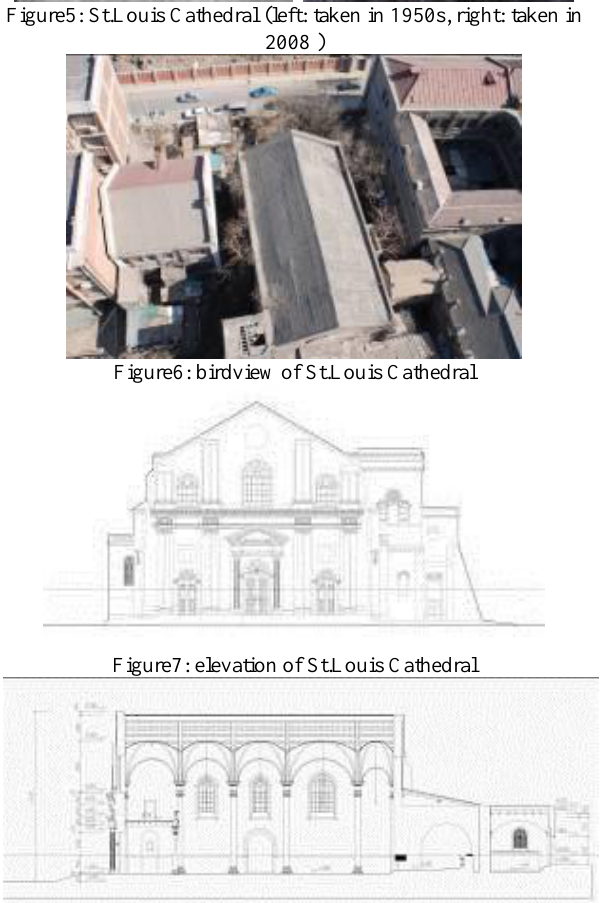
Figure8: section of St.Louis